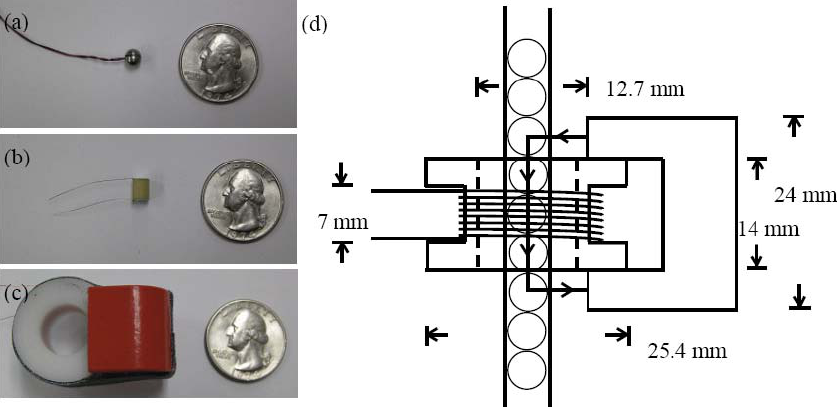
Figure 2. Sensing technologies used in this study. ( a ) Bead sensor formed by a thin piezoelectric crystal embedded between two half particles, ( b ) commercial piezo rod, ( c ) magnetostrictive sensor formed by a coil and a bridge magnet, ( d ) Schematic diagram of one magnetostrictive sensor assembled with the tube filled with spherical